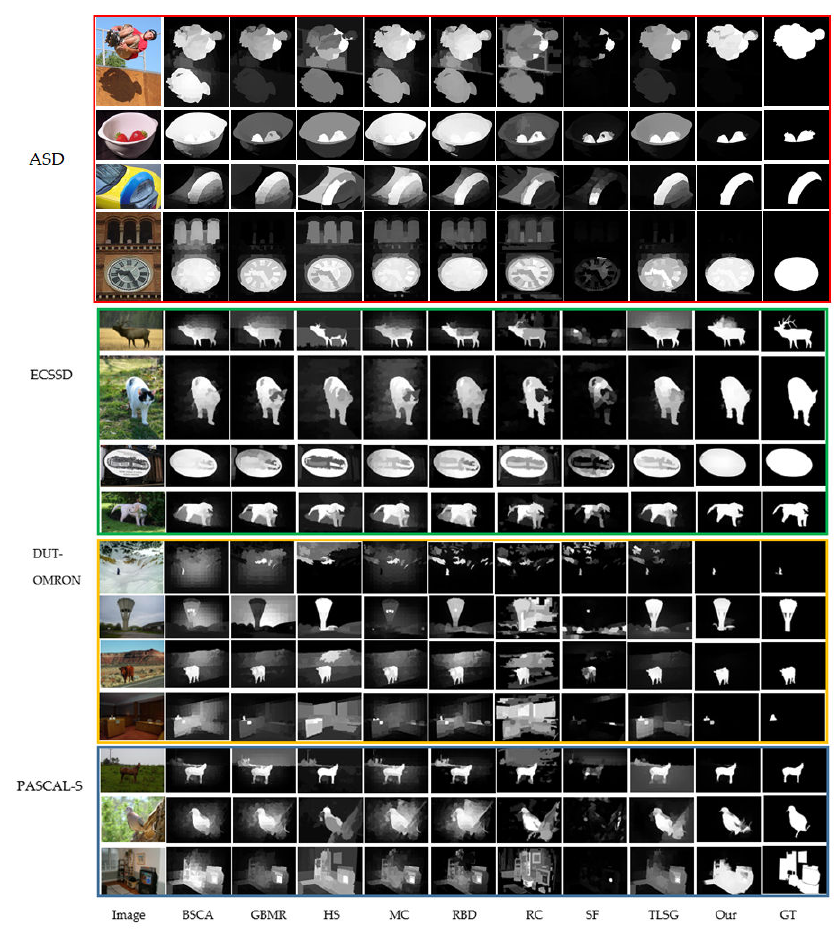
Figure 12. Visual comparison of state-of-the-art approaches to our method on four